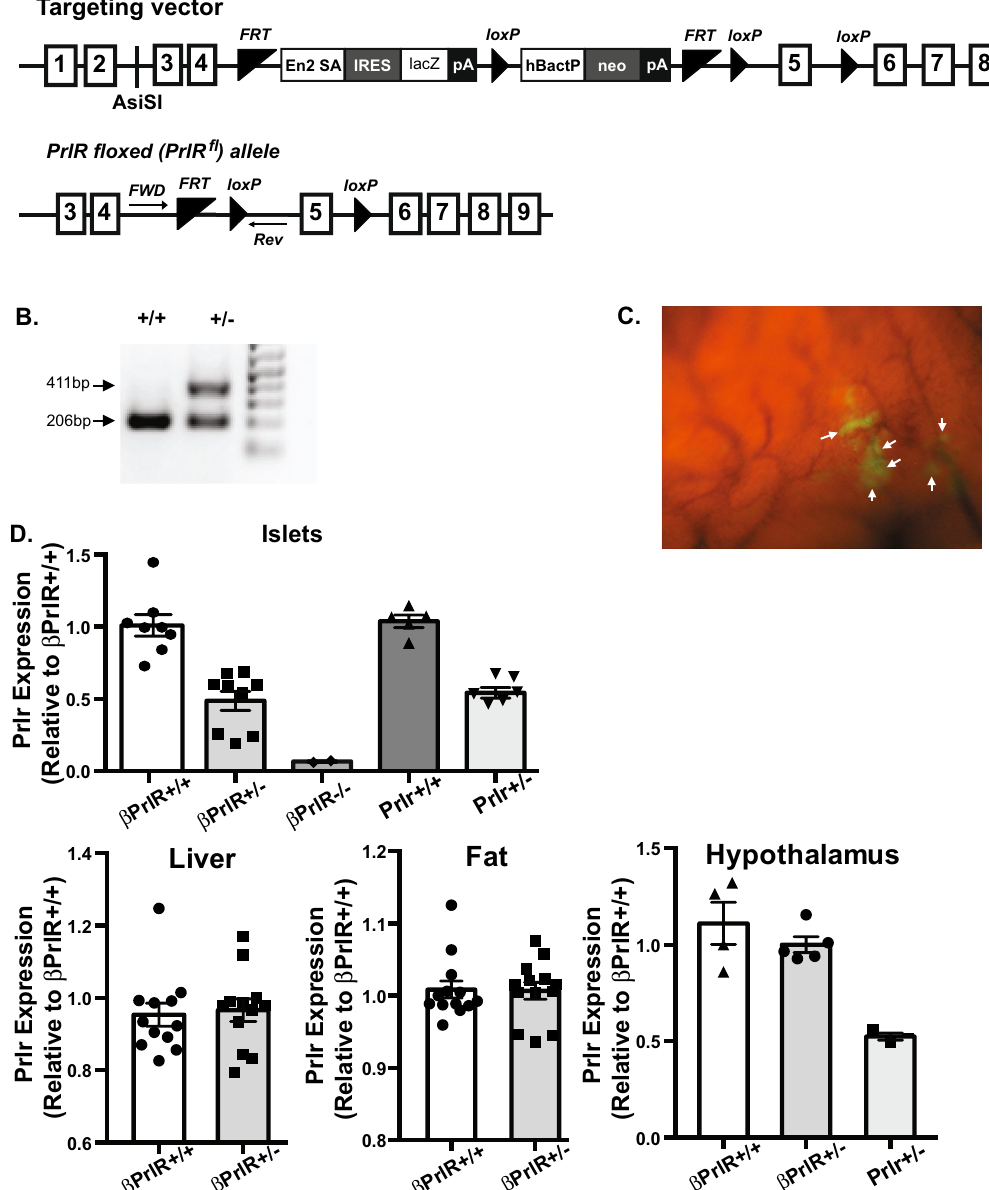
Figure 1. Conditional deletion of prolactin receptor (Prlr) from pancreatic β-cells. ( A ) Schematic diagram of the targeting vector and the floxed prolactin receptor, PrlR, allele. ( B ) Genotyping of litters that contain mice with heterozygous floxed PrlR allele (+/-) or homozygous wild type (non-floxed) PrlR allele (+/+). A subset of the result (mice #284 and 285) is shown here. The entire gel containing the genotyping result is presented in Supplementary Fig. S1. ( C ) Image of pancreas from a βPrlR −/− mouse expressing mT/mG, which allows detection of Cre recombination, visualized as green fluorescence (arrows). The areas of green fluorescence represent islets. ( D ) Relative mRNA expression of prolactin receptor in islets, liver, fat, and hypothalamus. n = 3–12 mice/genotype. “*” = p < 0.05 and “**” = p < 0.01 in comparison to the βPrlR +/+ mice. Prlr +/− and Prlr +/+ denote transgenic mice with a global, heterozygous deletion of prolactin receptor or their wild type littermates, respectively. βPrlR −/− and βPrlR +/− denote transgenic mice with a β-cell-specific homozygous or heterozygous prolactin receptor deletion, while βPrlR +/+ denotes their wild type